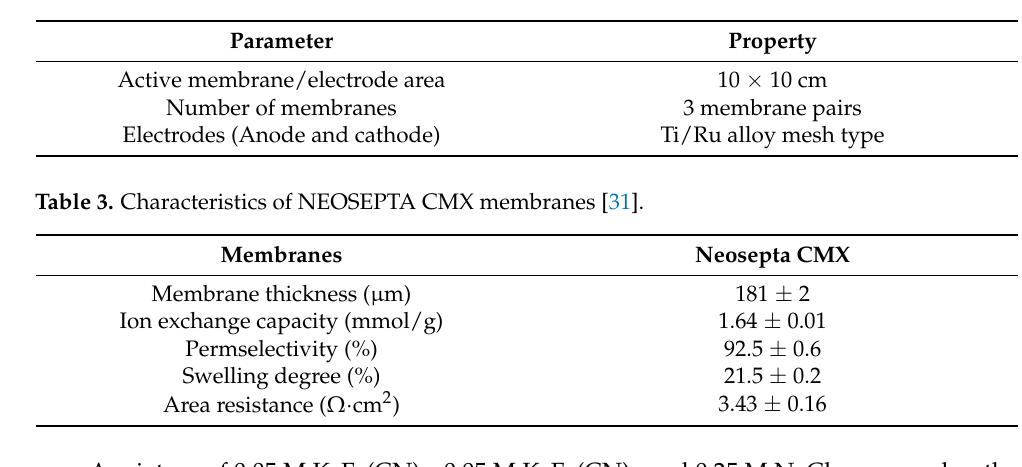
Table 2. Technical information of RED stack.